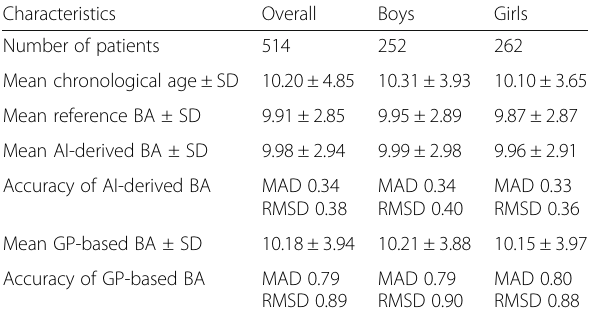
Table 2 Summary of main